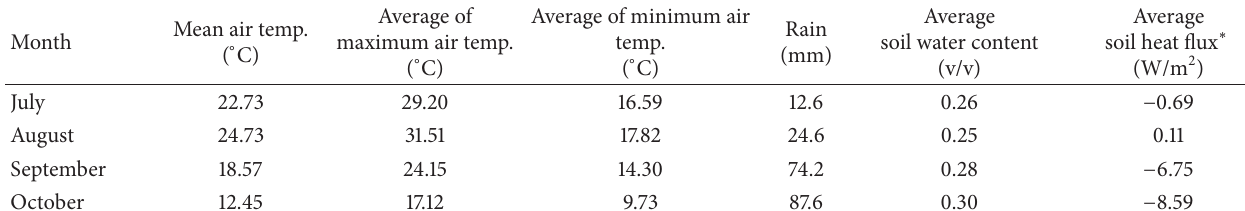
Table 3: Weather conditions measured at the NT site during the data measuring campaign.